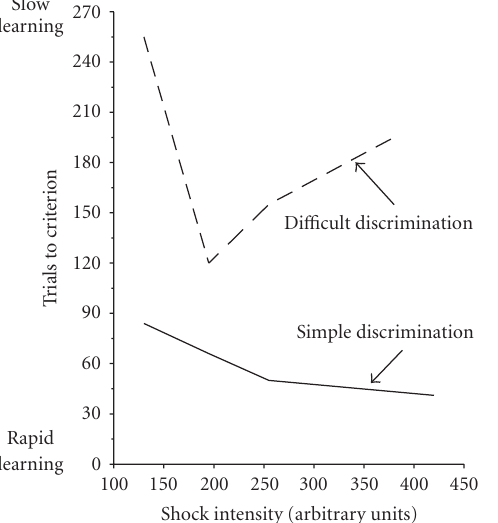
Figure 1: A subset of data from Yerkes and Dodson [38]. Mice were trained to avoid shock in a simple versus di ffi cult visual discrimina- tion task. The simple task involved a dark versus bright discrimina- tion and the more di ffi cult task involved a discrimination in which the two sides of the escape box were at similar levels of illumina- tion. Behavioral performance increased linearly with increased lev- els of shock in the simple task, but performance was maximal at an intermediate level of shock for mice trained in the di ffi cult discrim-